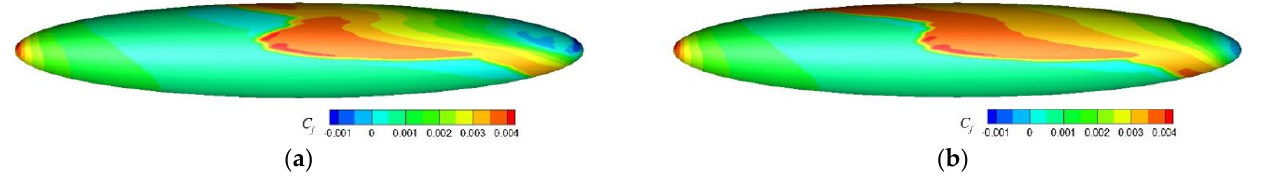
Figure 13. γ -Re θ t -CF SST-2003 transition model with present sustaining turbulence. ( a ) R T,FS =0.1. ( b ) R T,FS =1.0.